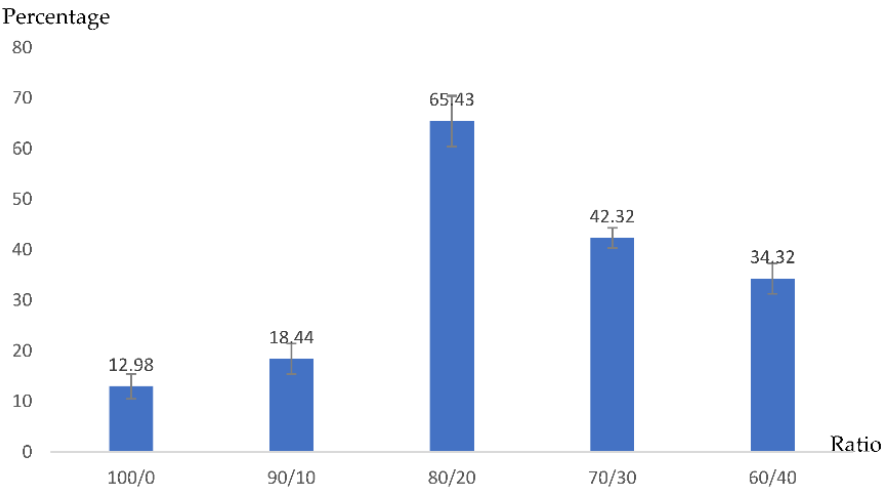
Figure 5. Swelling ratio of gelatin/Na 2 Ti 3 O 7 scaffold via salt-leaching technique. (n = 20).